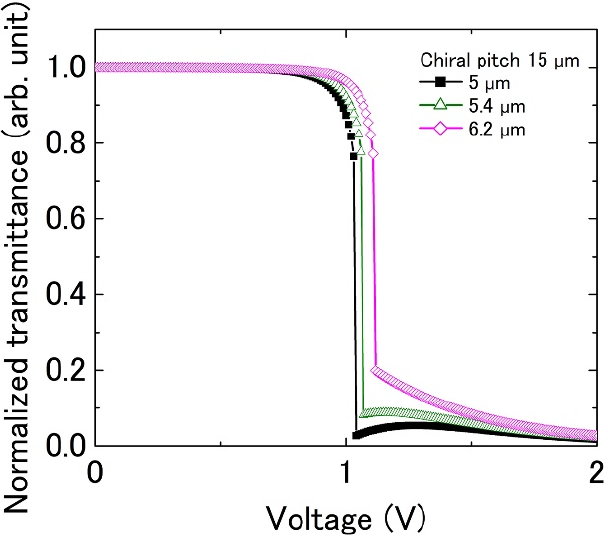
Figure 6. Transmittance as a function of the applied voltage for LPSTN (MLC-2173, chiral pitch 15.0 µm) with cell thicknesses of 5.0, 5.4, and 6.2 µm. The threshold and saturation voltage decreased with the cell thickness.